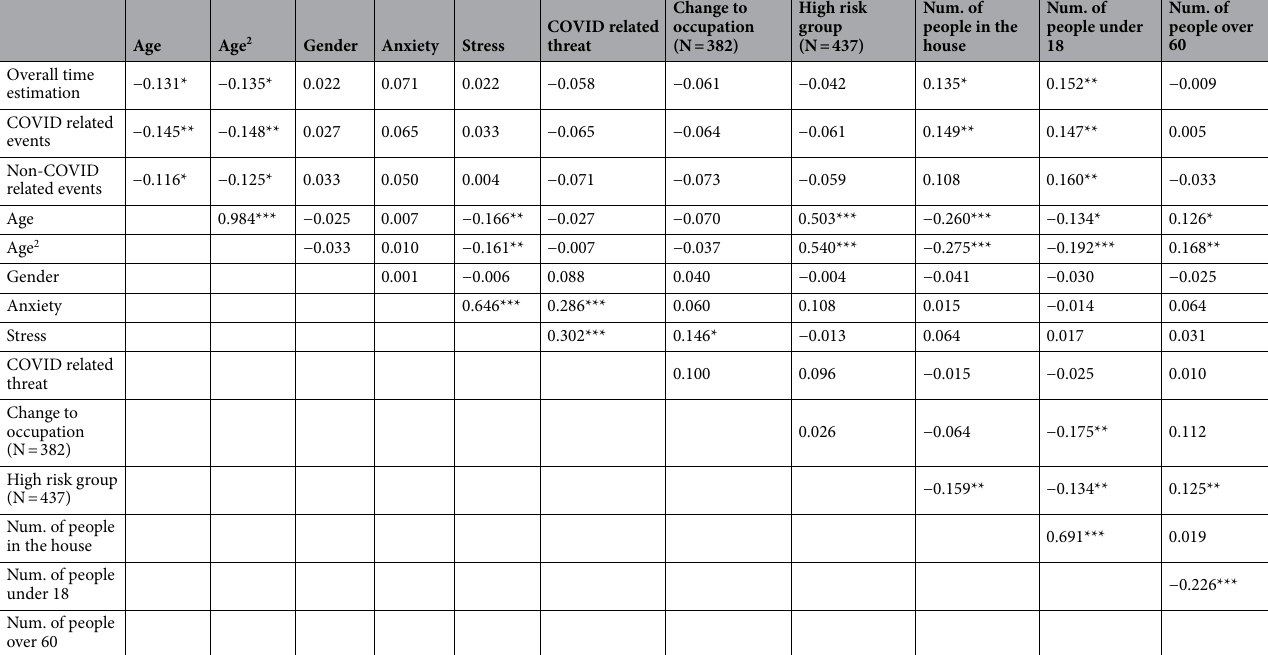
Table 1. Pearson correlation coefficient between time estimation measurements and demographic and psychological factors. Change to occupation due to COVID‑19: only participants who reported either keeping their job or losing their job following the COVID-19 outbreak, were included in the sample. Participants who chose “other” as an answer for this question, were removed from the sample for this correlation analysis (N = 86). High risk for COVID‑19: Participants who responded that they do not know whether they are at risk for COVID-19 or not, were removed from the sample for this correlation analysis (N = 31). * p < 0.05, ** p < 0.01, *** p < 0.001; all p -values were FDR